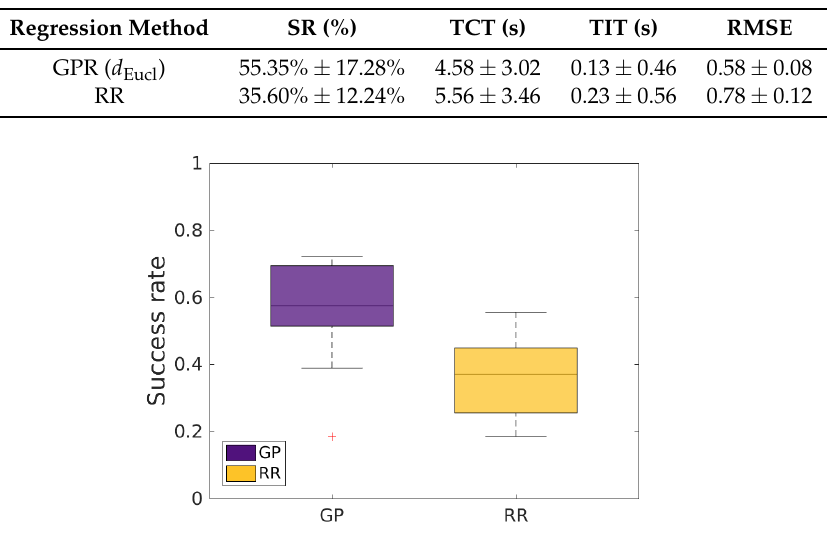
Table 1. Performance comparison in term of success rate (SR), time to complete the task (TCT) and time in the target (TIT) between Gaussian process regression (GPR) and ridge regression (RR) in experiment 1.